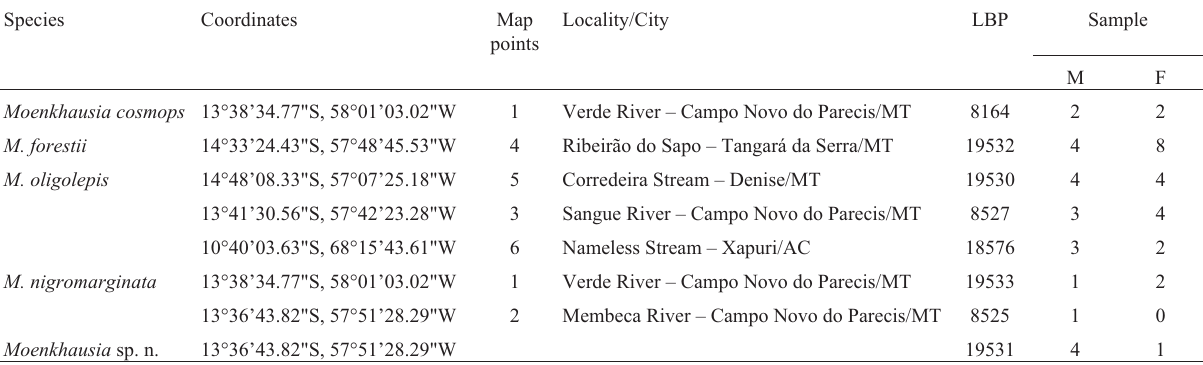
Table 1 - – Specimens of Moenkhausia collected. LBP: Coleção de Peixes Laboratório de Biologia e Genética de Peixes, Instituto de Biociências, UNESP; F: females; M: male.